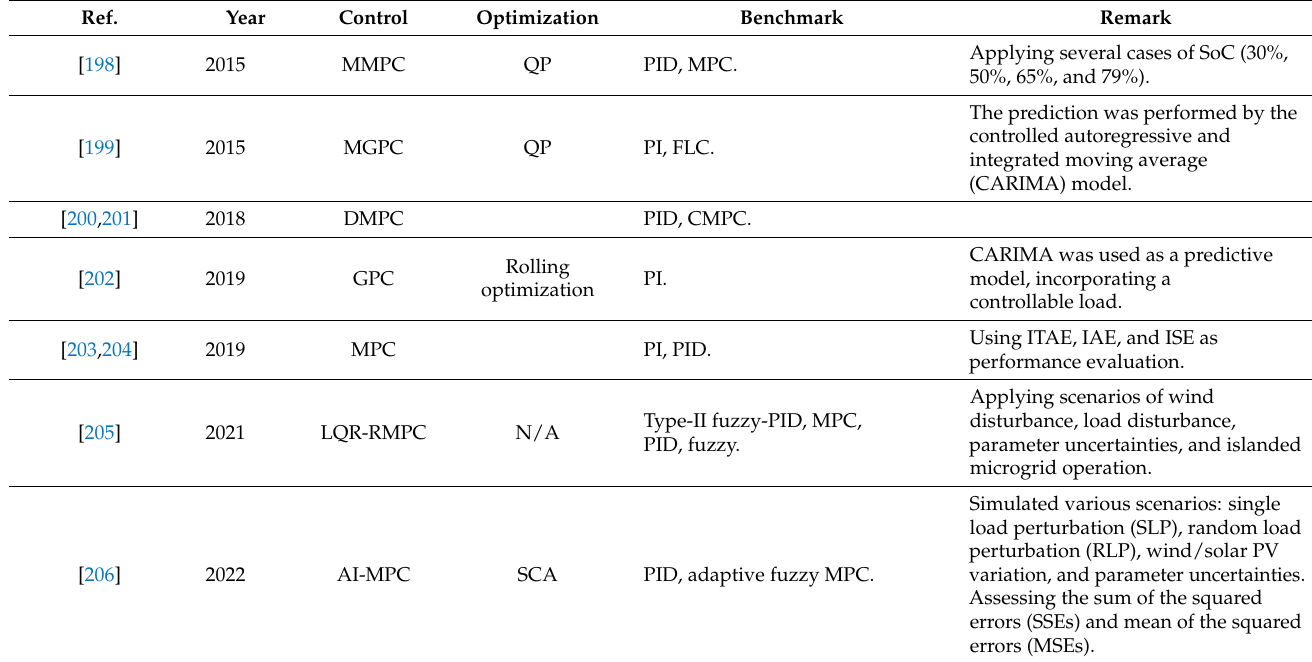
Table 4. EVAS as a frequency contingency service with MPC